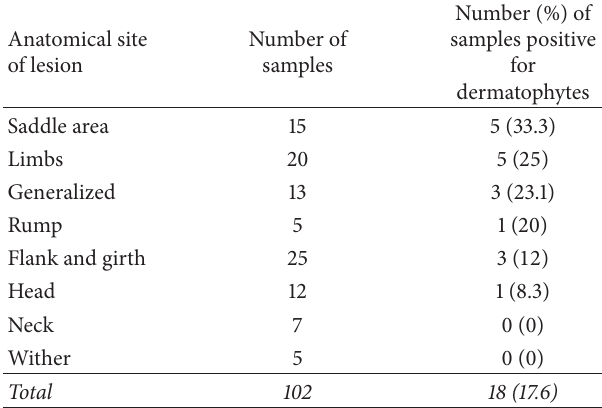
Table 1: Occurrence and distribution of dermatophytes based on anatomical site of lesion among horses with cutaneous skin lesions in Kaduna State,